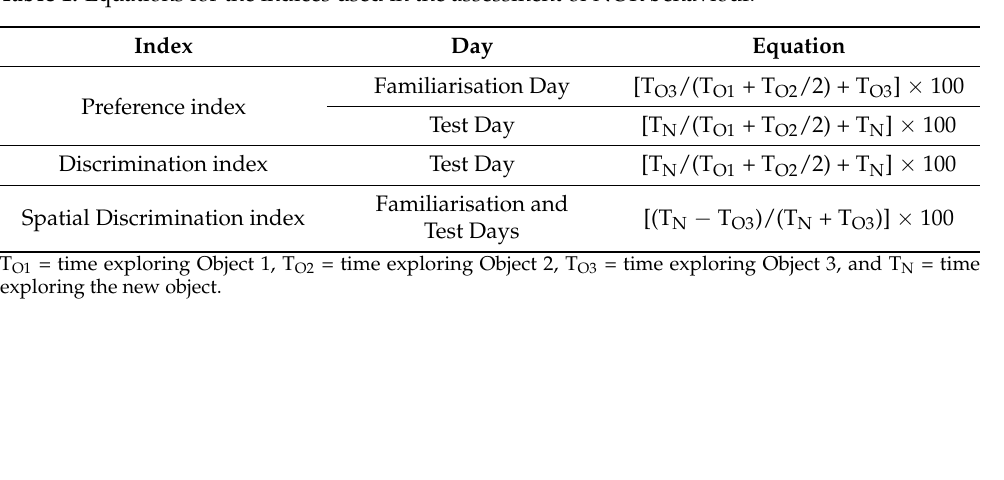
Table 1. Equations for the indices used in the assessment of NOR